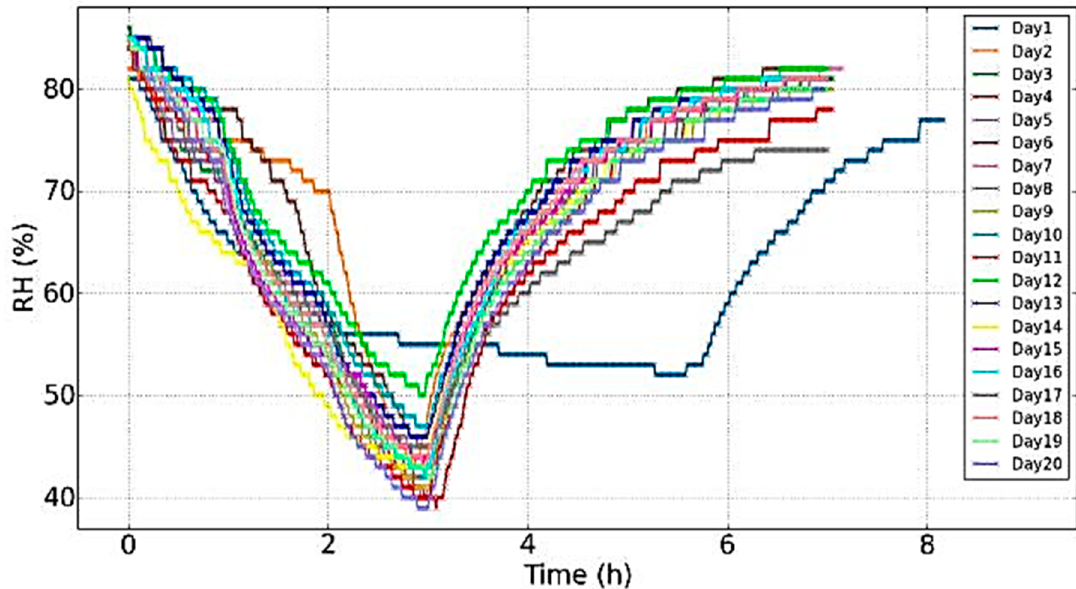
Figure 12. Evolution of the RH during the twenty days of Figure 12 . Evolution of the RH during the twenty days of experiments . Figure 12 . Evolution of the RH during the twenty days of experiments .